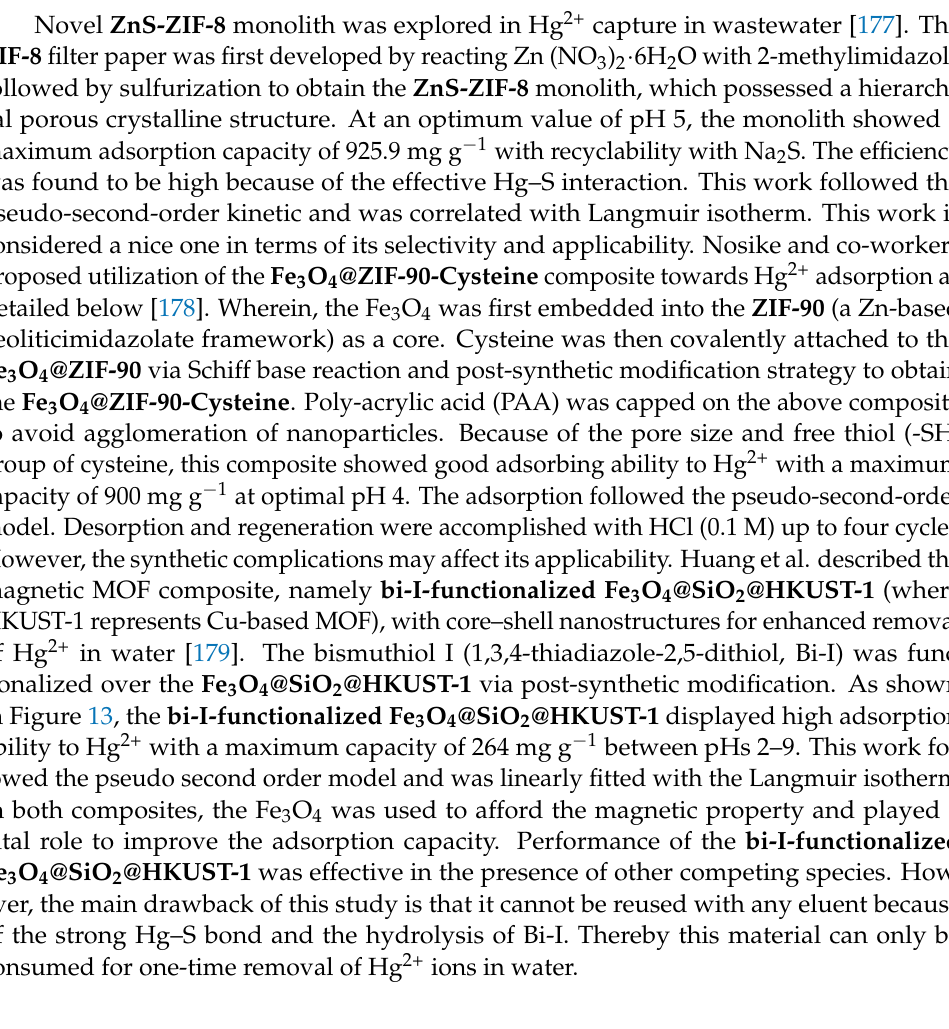
Figure 12. ( a ) Adsorption of mixed heavy metal ions (concentration of each ion was 100 mg L − 1 on the PCN-224-MAA/MF composite at pH 3. ( b ) Effect of pH on the removal of Hg 2+ ions with an initial concentration of 20 mg L − 1 on a PCN-224-MAA/MF (Reproduced with the permission from Ref